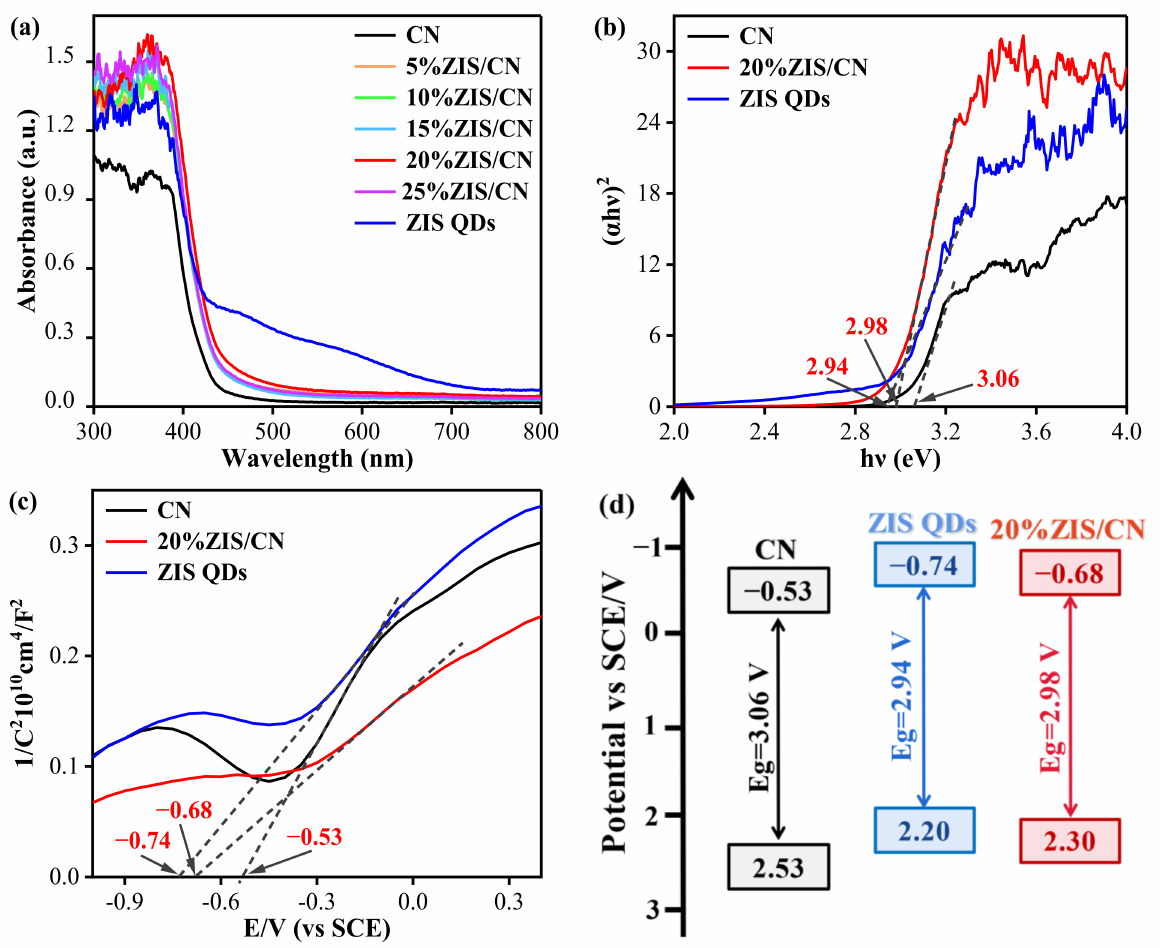
Figure 7. Photoelectric property of CN, ZIS QDs, and 20%ZIS/CN samples: ( a ) UV–Vis DRS spectra, ( b ) energy band gap, ( c ) flat band potential spectrogram, ( d ) energy band structure diagram. The Kubelka Munk [42] function was obtained by converting UV-vis data with Tauc formula (Equation (1)). Figure 7b shows the band gap (Eg) diagram of CN, ZIS QDs and 20%ZIS/CN